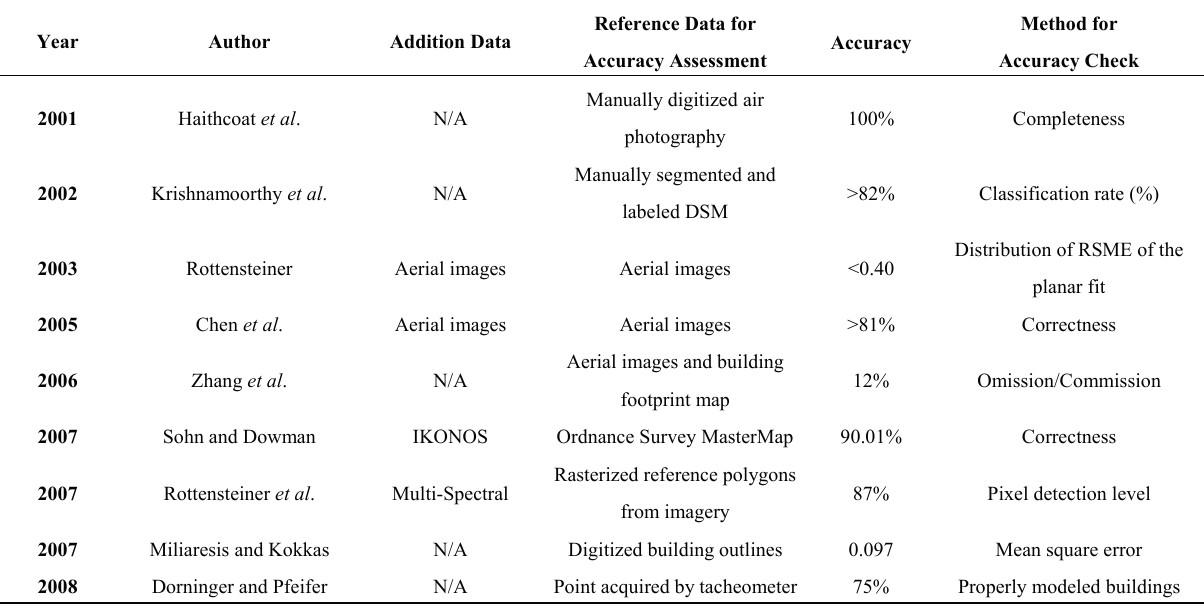
Table 4. List of ISI-indexed publications that provide accuracy measures within the publication along with additional information derived from the articles on additional data sources and on the accuracy